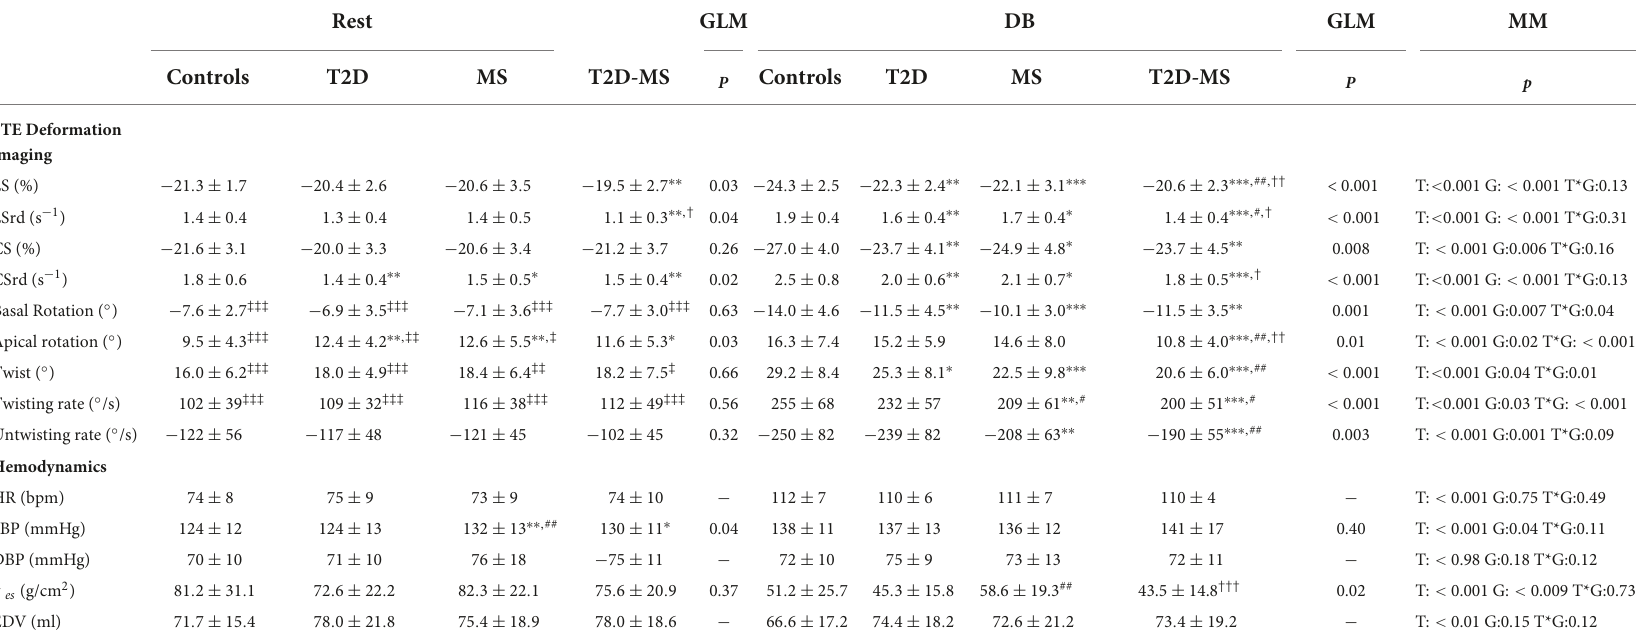
TABLE 3 Hemodynamic and speckle tracking echocardiography